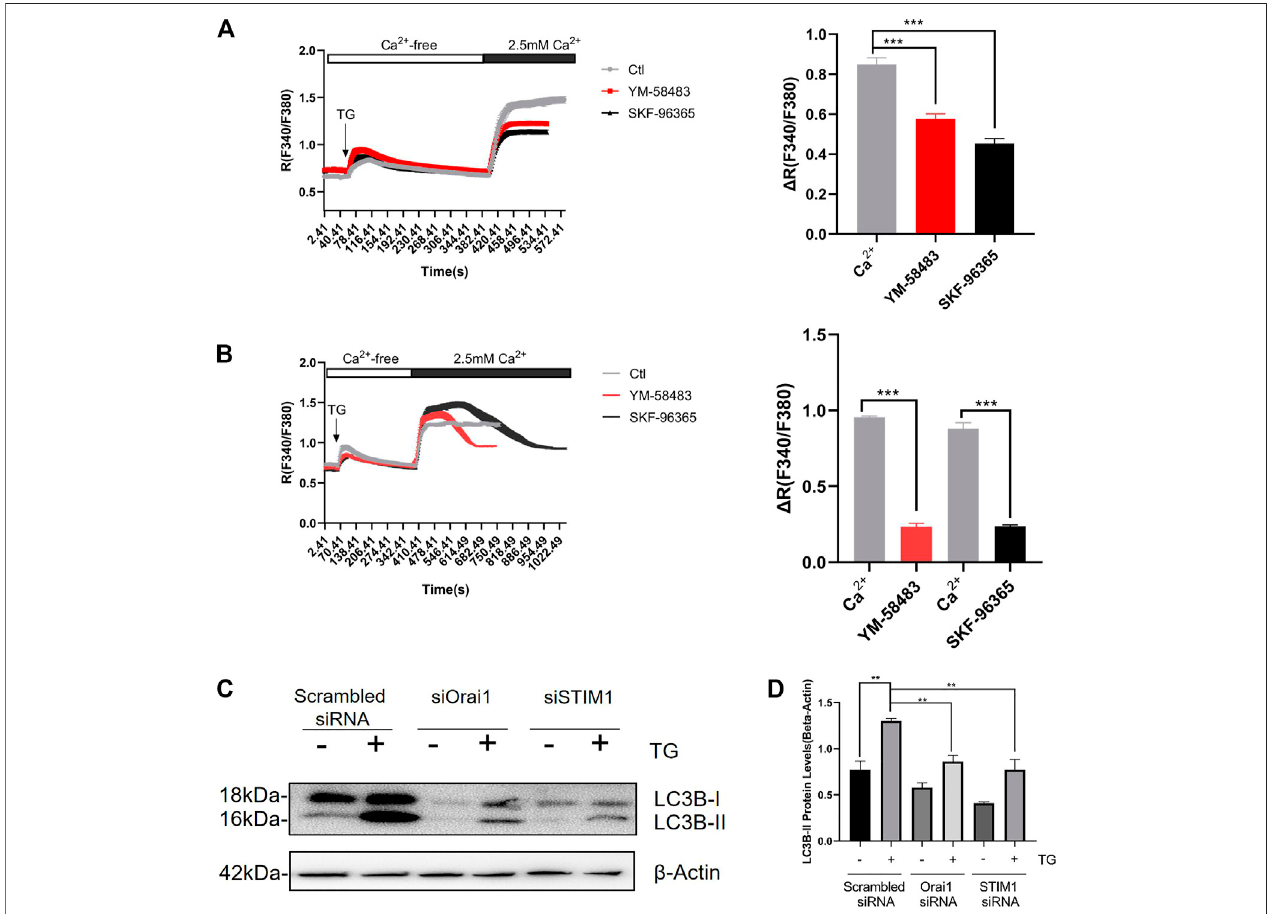
FIGURE 1 | SOCE regulates Ang II-induced autophagy in cardiomyocyte. Acute effect of YM-58483 and SKF-96365 on SOCE in cardiomyocytes. The cells were treatedwith4 μ mol/Lthapsigargin(TG)inaCa 2+ -freebathto fi rstinducetheriseinCa 2+ ,followedbytheadditionof2.5 mmol/LCa 2+ toinduceasecondriseinCa 2+ .The second time risein Ca 2+ isdue toSOCE (A) YM-58483 (3 μ mol/L) and SKF-96365 (10 μ mol/L)wereapplied respectively 5 min before TGtreatment. The representative traces (left) and data summary (right) related to Ca 2+ responses are shown (B) YM-58483 (3 μ mol/L) and SKF-96365 (10 μ mol/L) were correspondingly applied after the addition of 2.5 mmol/L Ca 2+ to the bath. The representative traces (left) and data summary (right) of Ca 2+ responses are shown. Only SOCE is plotted in the summary chart. Knockdown of Orai1/STIM1 attenuated TG-induced autophagy (C) NRCMs treated with or without Orai1/STIM1 siRNA were incubated with TG for 24 h. The representative images are showing LC3-II protein levels and summarize data. ** p < 0.01, and *** p < 0.001.